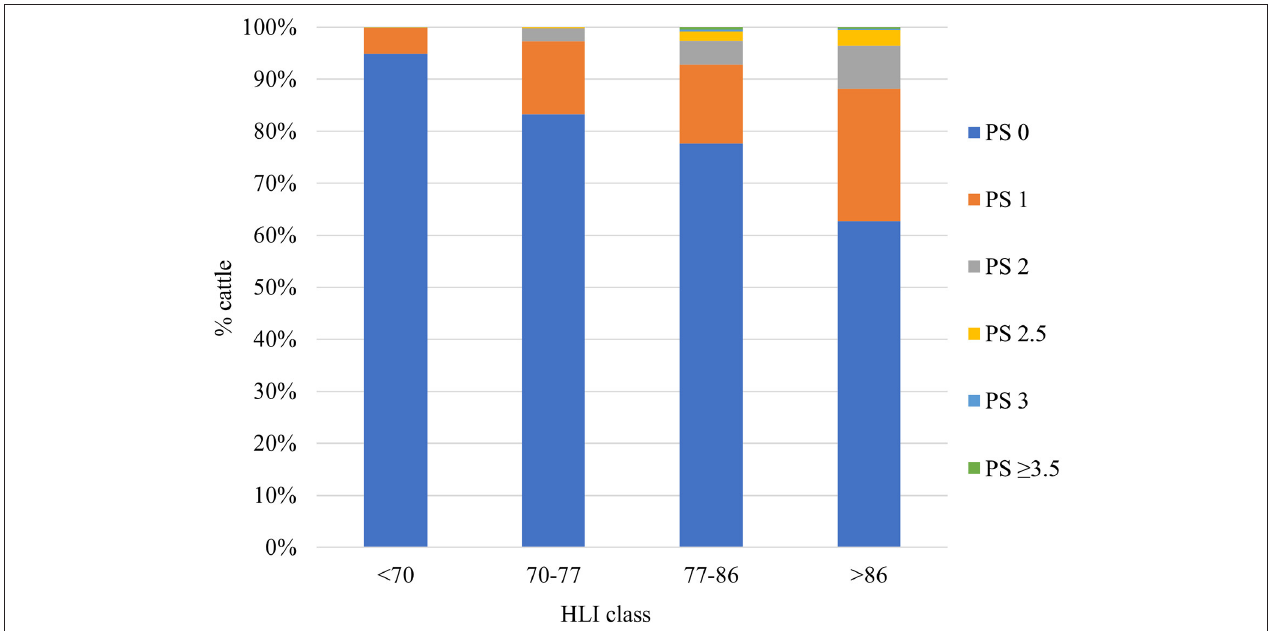
FIGURE 1 | Percentage of cattle showing different panting scores under various heat load index (HLI) categories based on data synthesised from Gaughan et al. (2008). The cattle percentages are average values for six cattle types including Bos taurus , Bos indicus and Bos taurus × Bos indicus genotypes under shaded and unshaded conditions generating four different thermal conditions for all. The HLI classes are thermoneutral ( < 70), warm (70–77), hot (77–86) and very hot ( > 86).